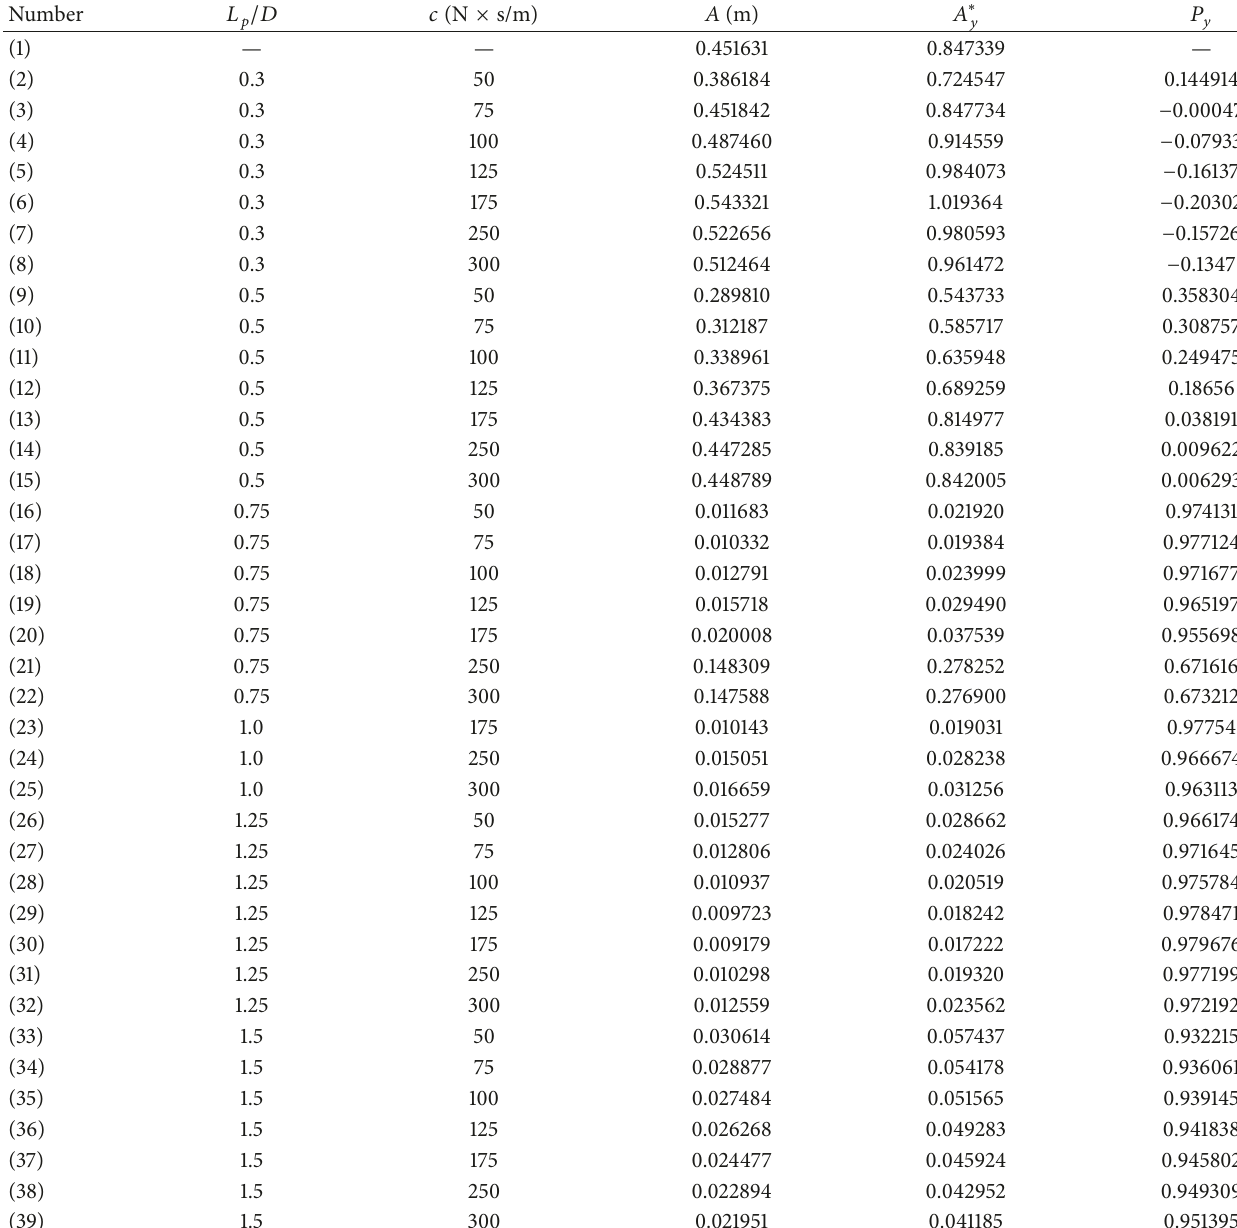
Table 6: Numerical simulation parameter data display